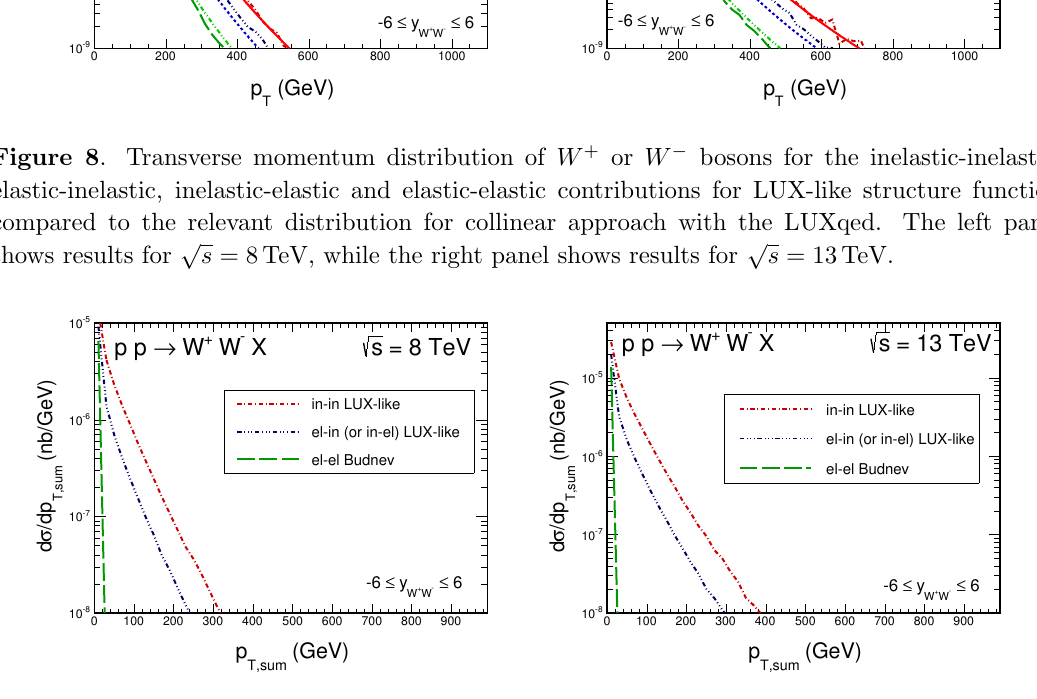
(GeV) p T,sum Figure 9 . Distribution in transverse momentum of the W + W (cid:0) pairs for the inelastic-inelastic, elastic-inelastic, inelastic-elastic and elastic-elastic contributions for the LUX-like structure func-